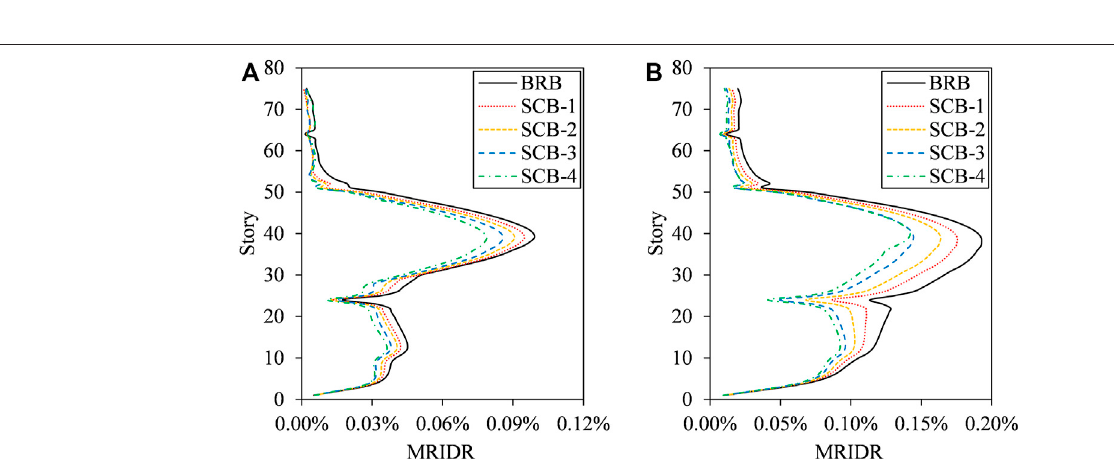
Frontiers in Materials |